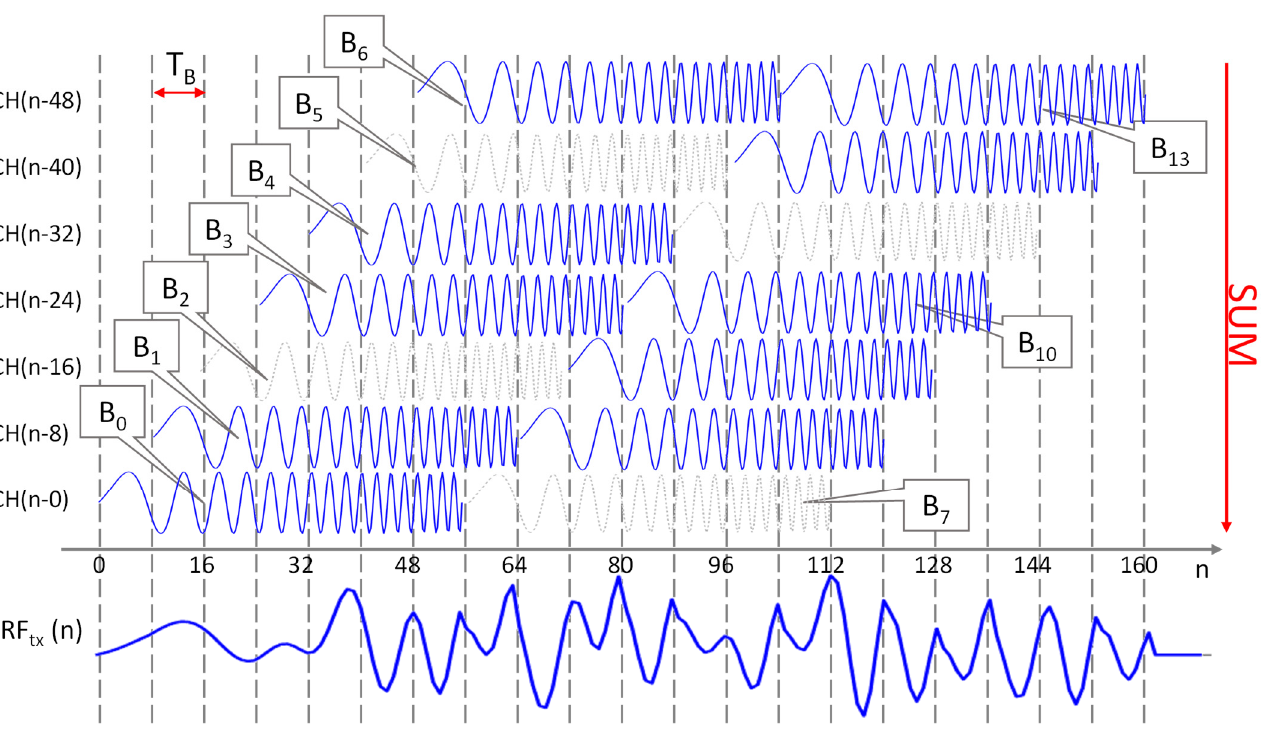
Figure 2. Example of the modulation scheme. The RF tx ( n ) (bottom) is obtained by summing up the chirps delayed by T B and zeroed for ‘0’ bits. Here the arbitrary 14-bit sequence “11011101011011” is transmitted with LSB first.